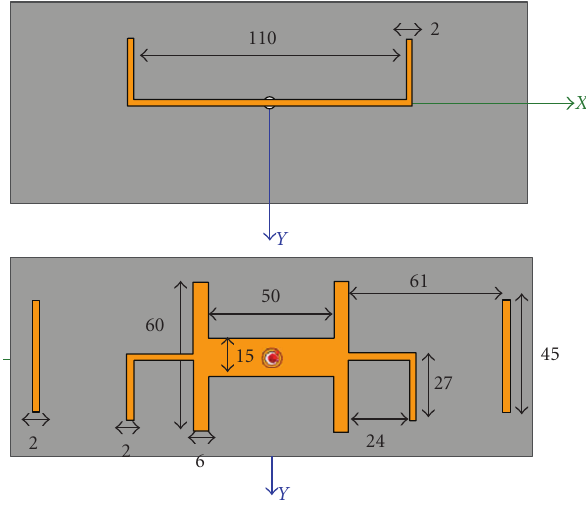
Figure 15: Geometry (in mm) of the dual-beam printed dipole